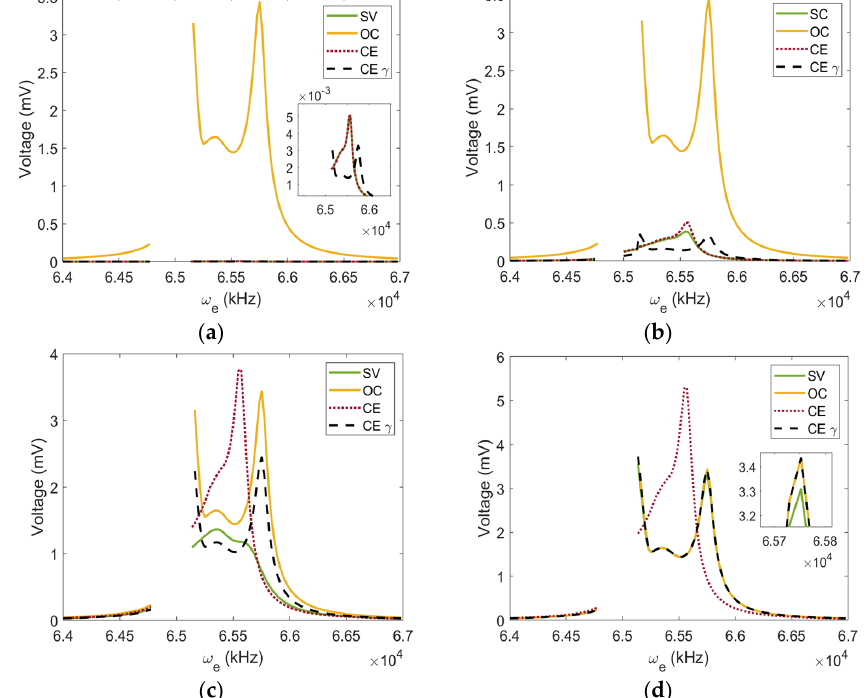
Figure 10. Voltage output variations as a function of the excitation frequency: ( a ) 𝑅 = 10 (cid:2871) Ω , ( b ) 𝑅 = 10 (cid:2873) Ω , ( c ) 𝑅 = (cid:2869) Ω , and ( d ) 𝑅 = 10 (cid:2876) Ω when 𝑉 (cid:3005)(cid:3004) = 1𝑉 , 𝑉 (cid:3002)(cid:3004) = 0.5 V, Ω = 80 (cid:3045)(cid:3028)(cid:3031) (cid:3004) (cid:3291) (cid:3104) (cid:3289)